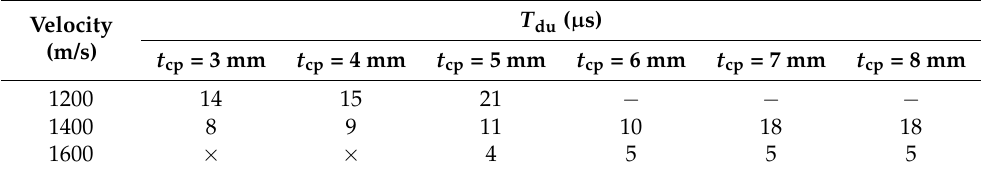
Table 6. Dwell duration in cases with the free cover plate.